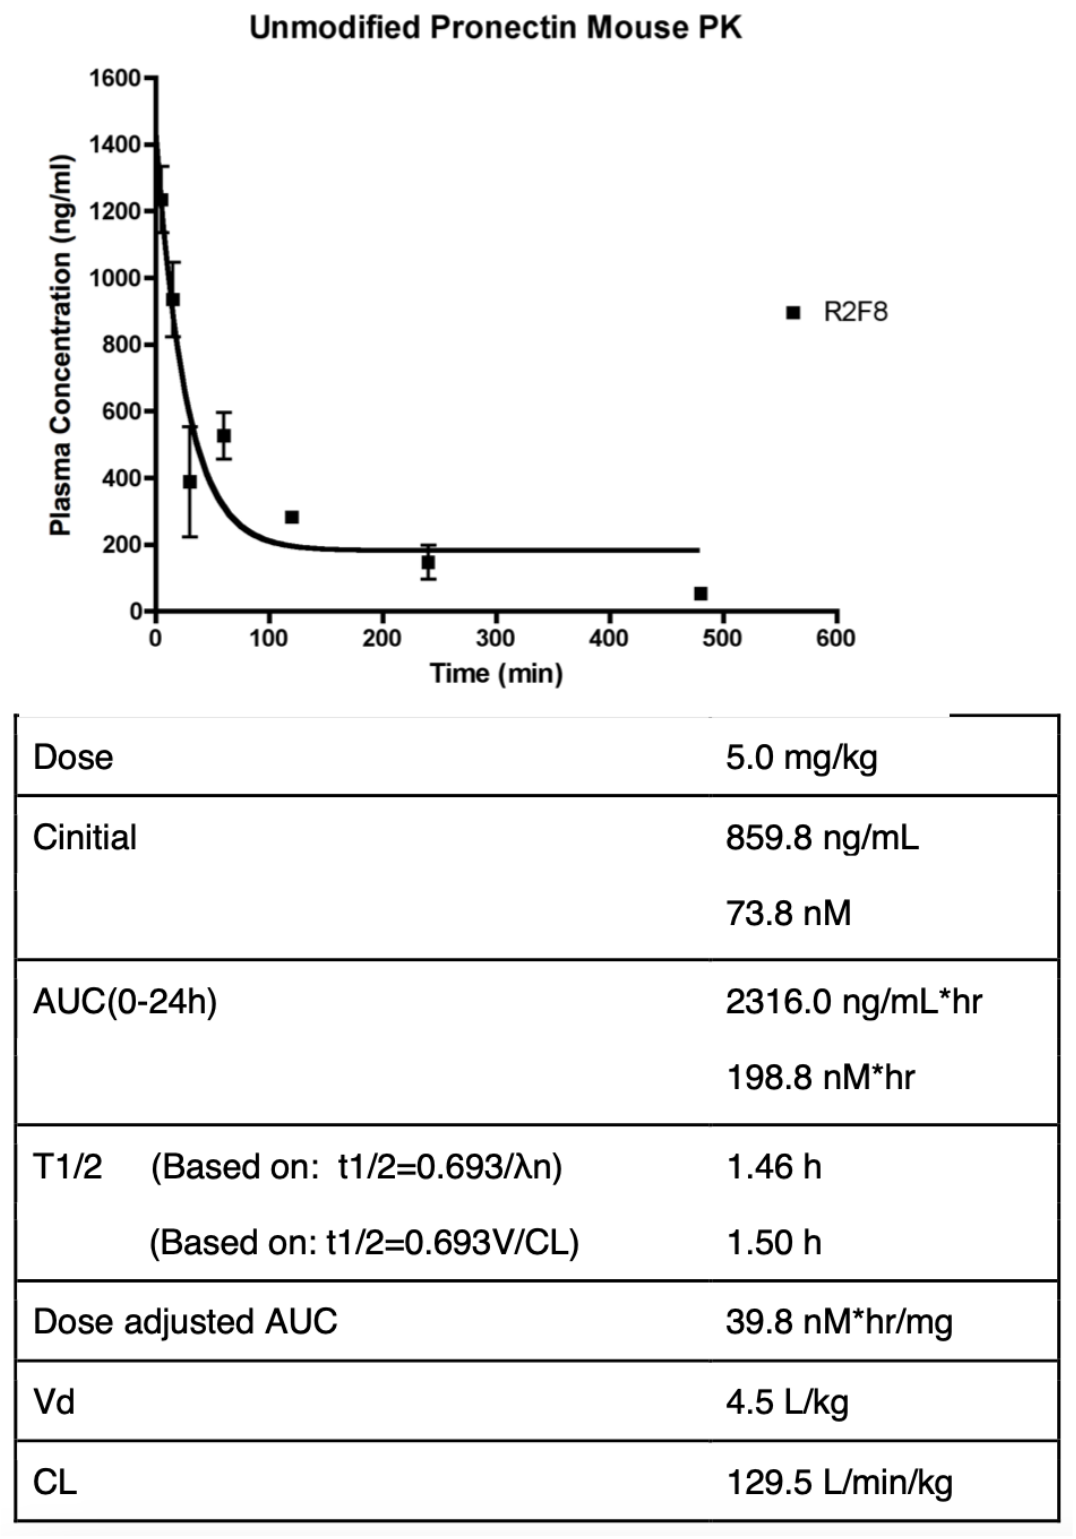
Figure 3. The pharmacokinetic profile and calculated values after administration of 5 mg/kg to BALB/C mice. The half-life of the Pronectin (R2F8) is 1.5 h. From the above studies, Pronectins were determined to be a viable non-immunoglobulin single domain best suited for applications as a bispecific protein. In the following